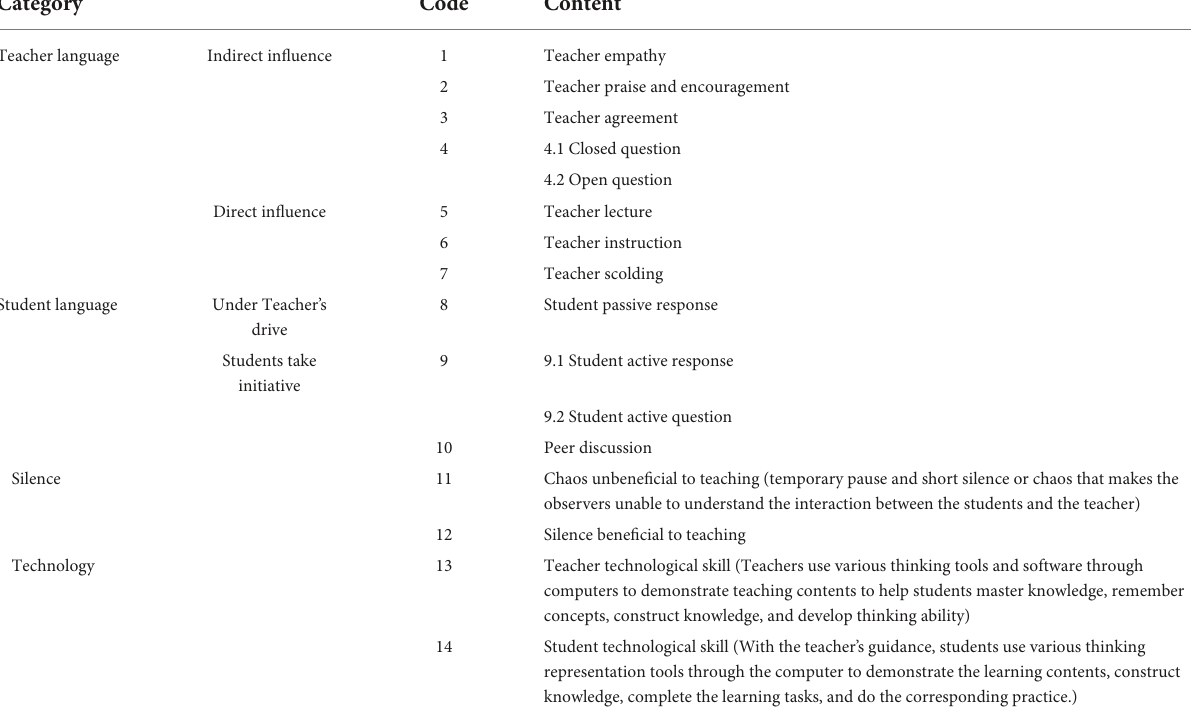
TABLE 2 Record of classroom